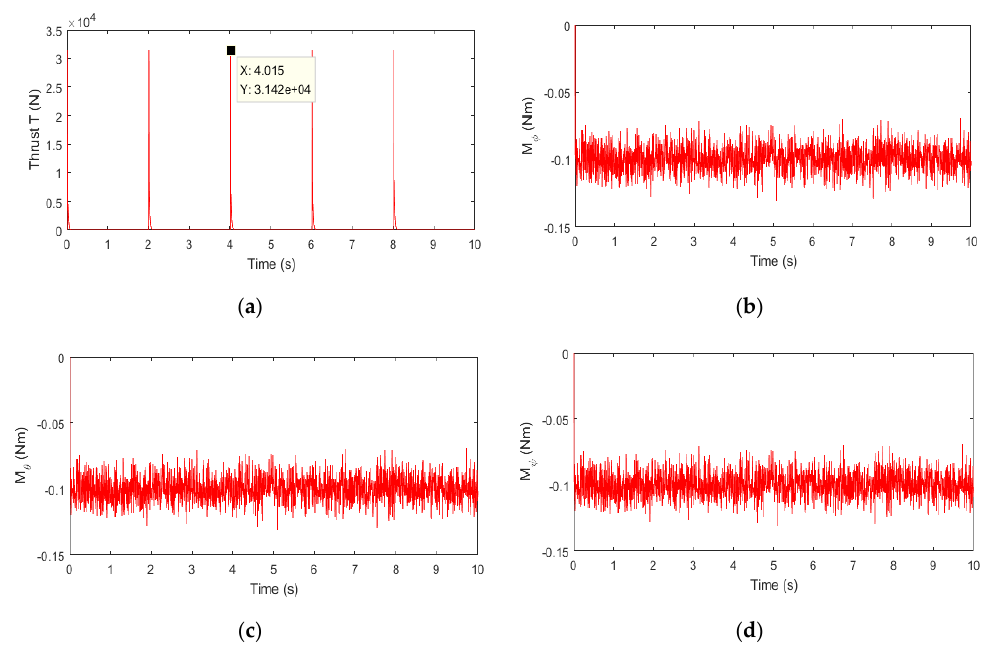
Figure 7. ( a ) Virtual control input: total thrust T . ( b – d ) Rotational torques M φ , M θ , and M ψ .